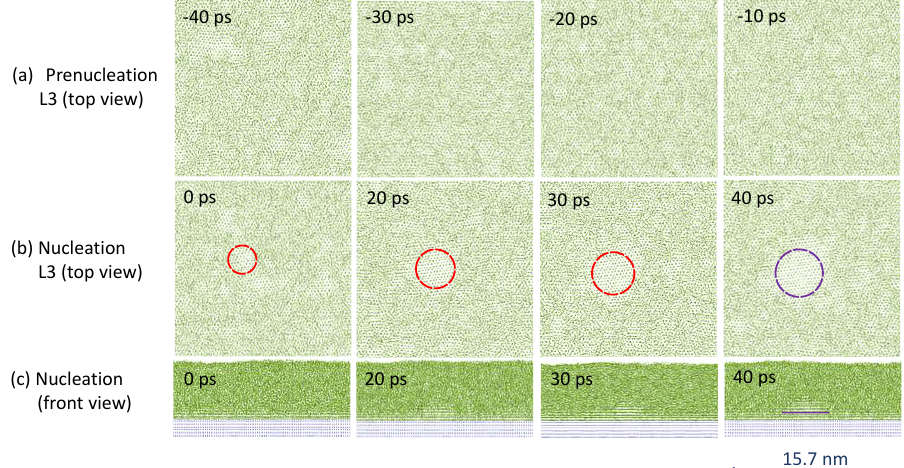
Figure 6. Demonstration of heterogeneous nucleation in the case of r N > r n . Time-averaged atomic positions of a system with − 8% lattice misfit showing the evolution of atomic arrangement in L3 (top view) and in the system (front view) during heterogeneous nucleation process. ( a ) at the prenucleation stage ( t < 0 ps), there exists dynamically unstable ordered atomic clusters; and ( b , c ) nucleation occurs at Δ T n = 136 K, starts at t = 0 ps and finishes at t = 40 ps to provide a 2D nucleus with 2 r n = 4.2 nm on a substrate of 2 r N = 15.7 nm ( Δ T gi = 36 K).